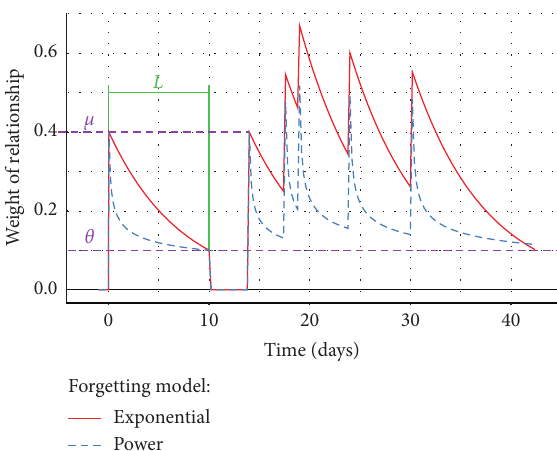
Figure 2: Dynamics of relations in CogSNet network with exponential and power functions and with parameters set to μ � 0 . 4, θ � 0 . 1, and L � 10